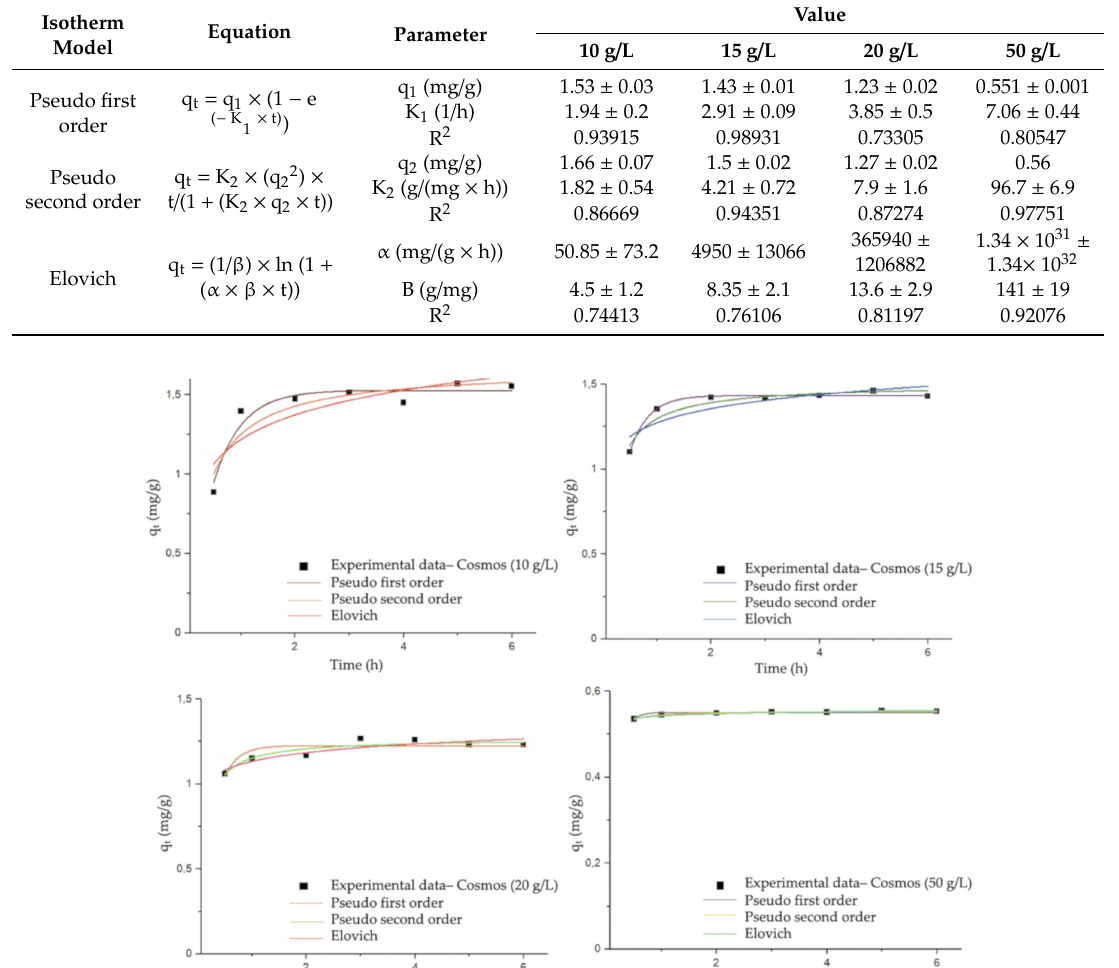
Figure 4. Nonlinear kinetic models for the adsorption of DCF onto COSMOS (sample A) at di ff erent dosages (10 g / L, 15 g / L, 20 g / L, 50 g / L). The fit was performed by Origin v.15.0 data analysis